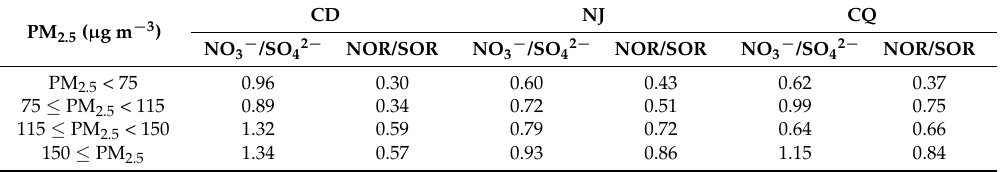
Table 4. NO 3 − /SO 42 − ratios and NOR/SOR ratios under four different PM 2.5 levels.